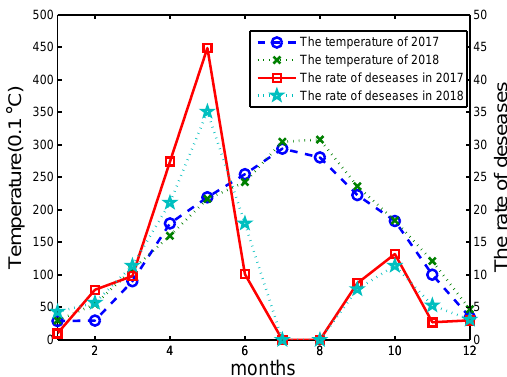
Figure 15. The temperature and wheat incidence in Yangtze River Zone of China from 2017 to